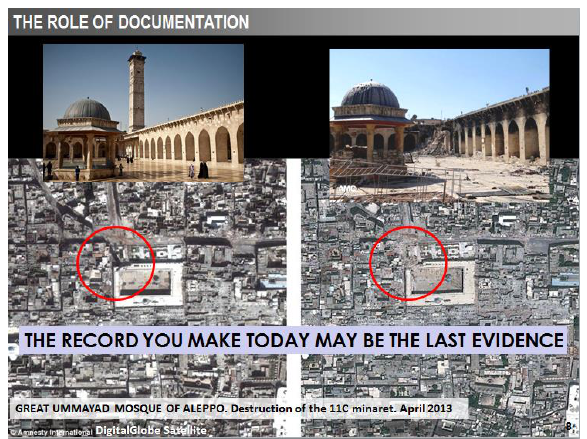
Figure 3. Image before and after recent destruction in Aleppo, Syria with satellite imagery